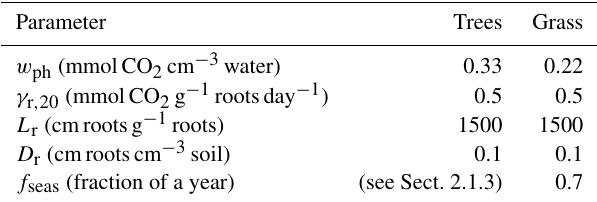
Table 1. Values of the vegetation parameters needed for the optimal rooting depth model, based on Donohue et al.